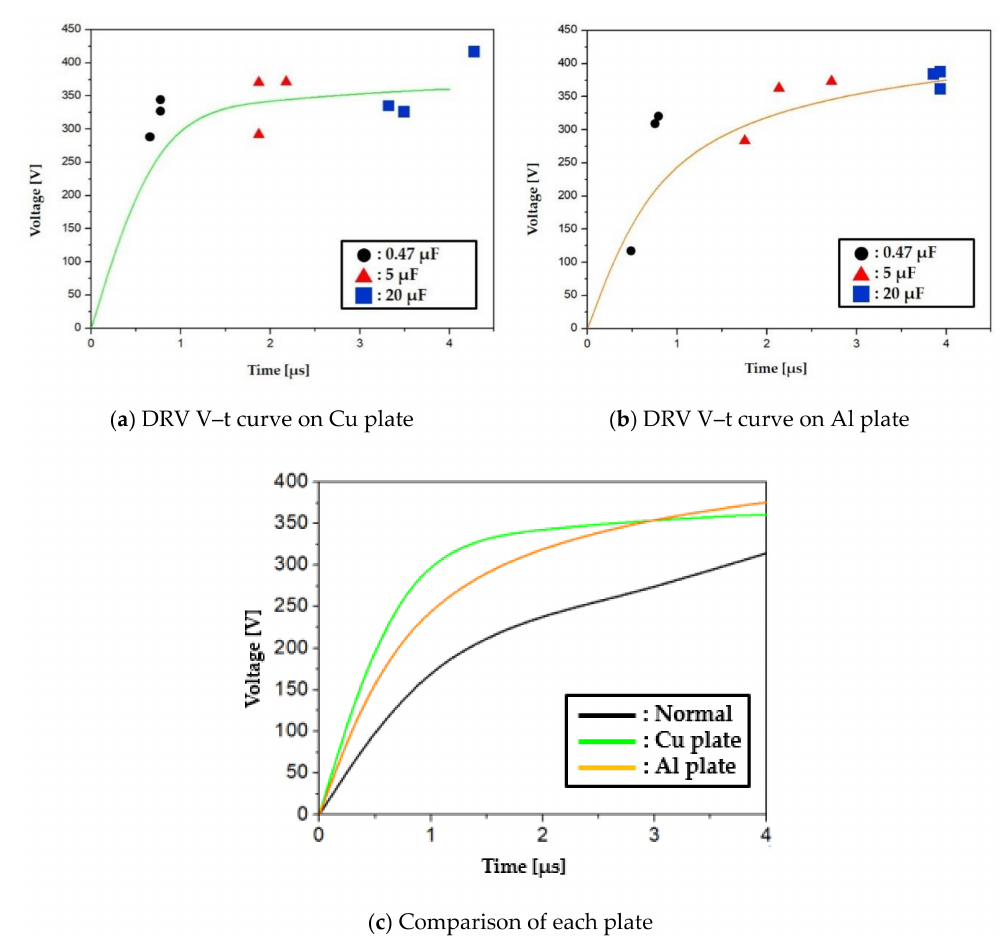
Figure 6. Dielectric recovery voltage V–t curve (according to plate materials). Table 2. Test results according to plate